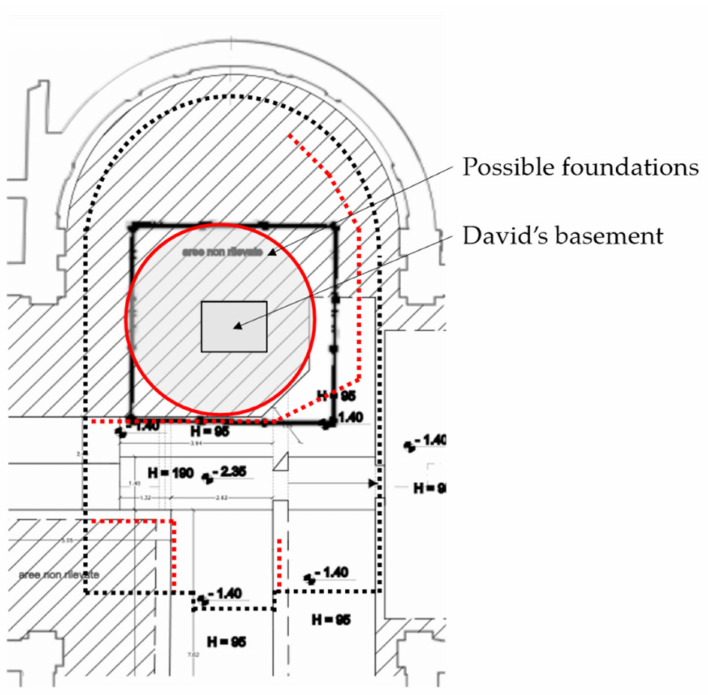
Figure 14. Schematic representation of the results of GRP